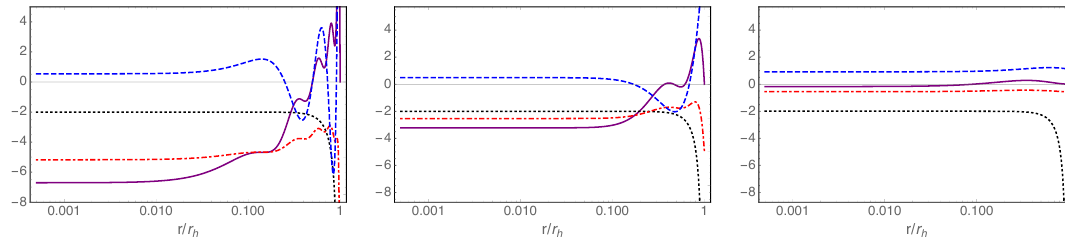
Figure 1 . Three typical examples of the configuration in the neutral helical black hole interior with fixing α b = 0 . 1 at different temperatures T/k = 0 . 05 ( left ), 0 . 1 ( middle ) and 0 . 3 ( right ). The functions we plot are rf 0 / ( α 2 f ) (purple), rα 0 /α h (blue), ( rh 0 /h − 1) / (4 α 2 h